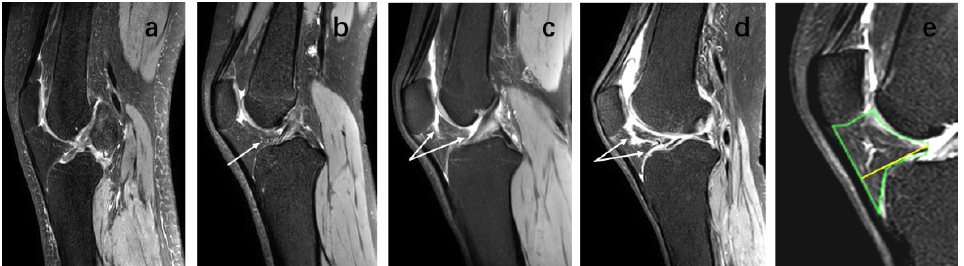
Figure 3. IPFP signal intensity alteration, IPFP maximum cross-sectional area (CSA) and IPFP depth on sagittal planes of T2-weighted images. IPFP signal intensity alteration graded as follows: ( a ) Grade 0 = none; ( b ) Grade 1 ≤ 10% of the area; ( c ) Grade 2 = 10–20% of the area; ( d ) Grade 3 ≥ 20% of the area. The area indicated by the white arrow within the IPFP represent the high signal regions. ( e ) The green area indicates the IPFP maximum CSA. The yellow line which perpendicular to the patellar tendon was drawn from the anterior to posterior surface indicates IPFP depth.